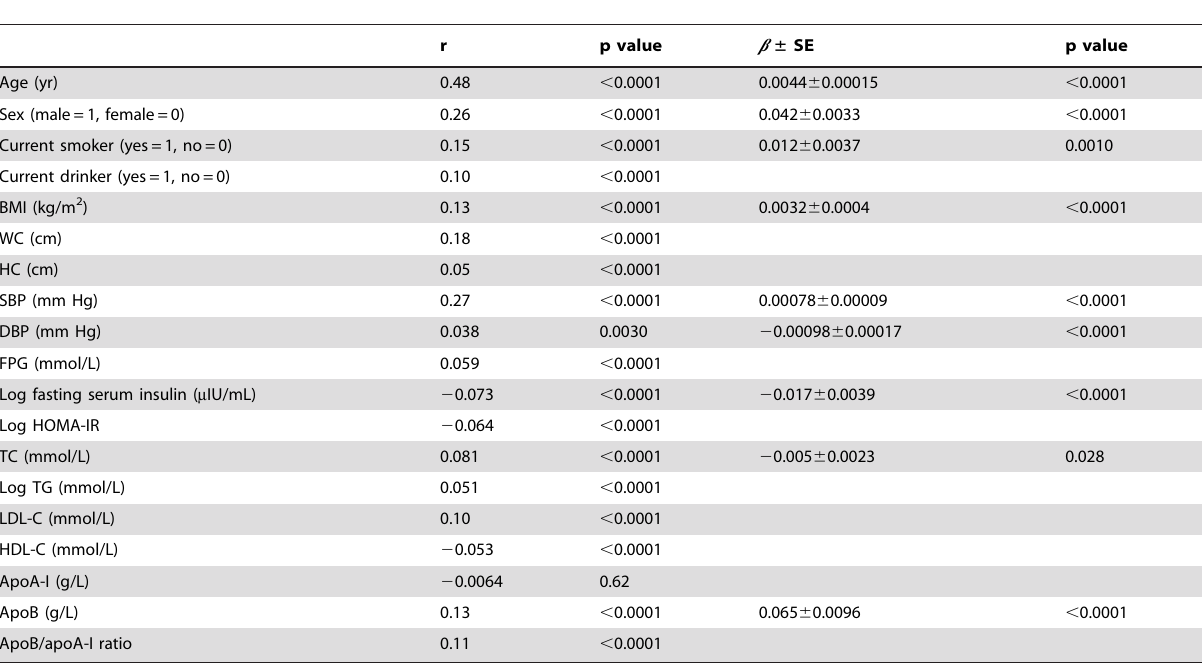
Table 2. Pearson’s correlation and multiple stepwise linear regression analysis of risk factors associated with